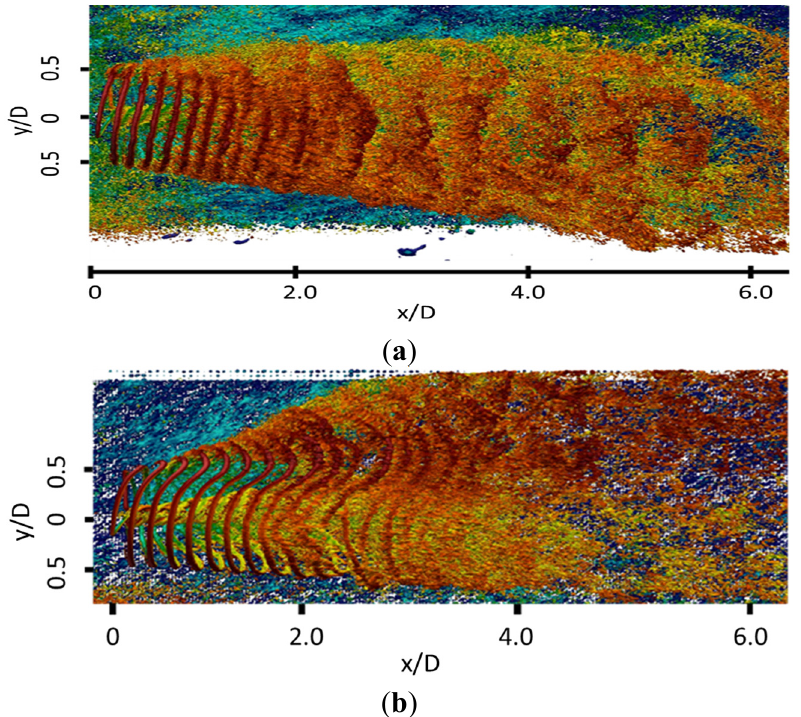
Figure 10. Structure of the wake in the horizontal plane (top-view) from the λ 2